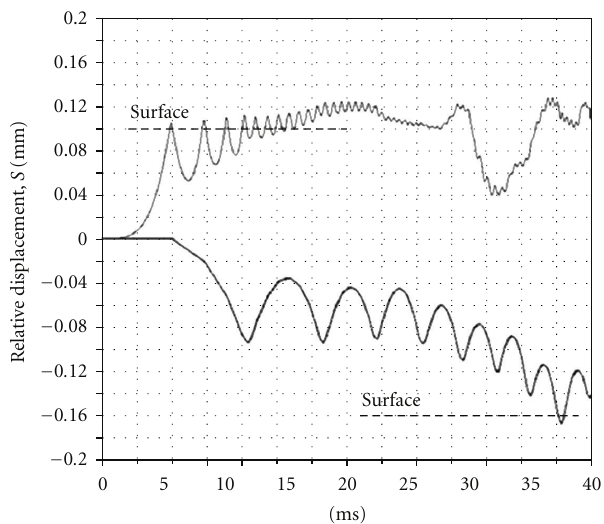
Figure 7: Comparison of relative displacements S along the line of action on Stage 1 and Stage 2 with step input torque 149.123 N-m.